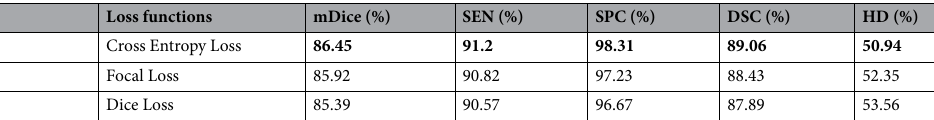
Table 5. Changes of evaluation index values under different Loss Functions. The best results are in bold.